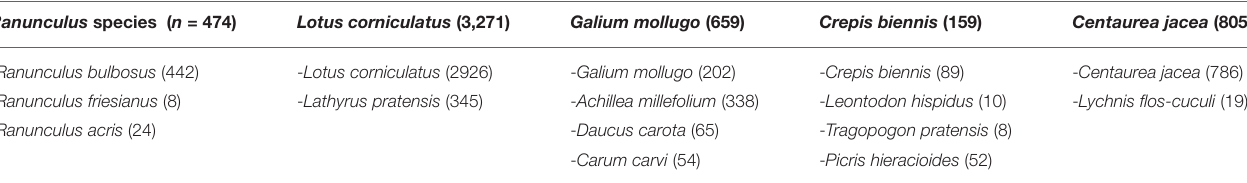
TABLE 1 | Groups of plant species that were combined into one group (table